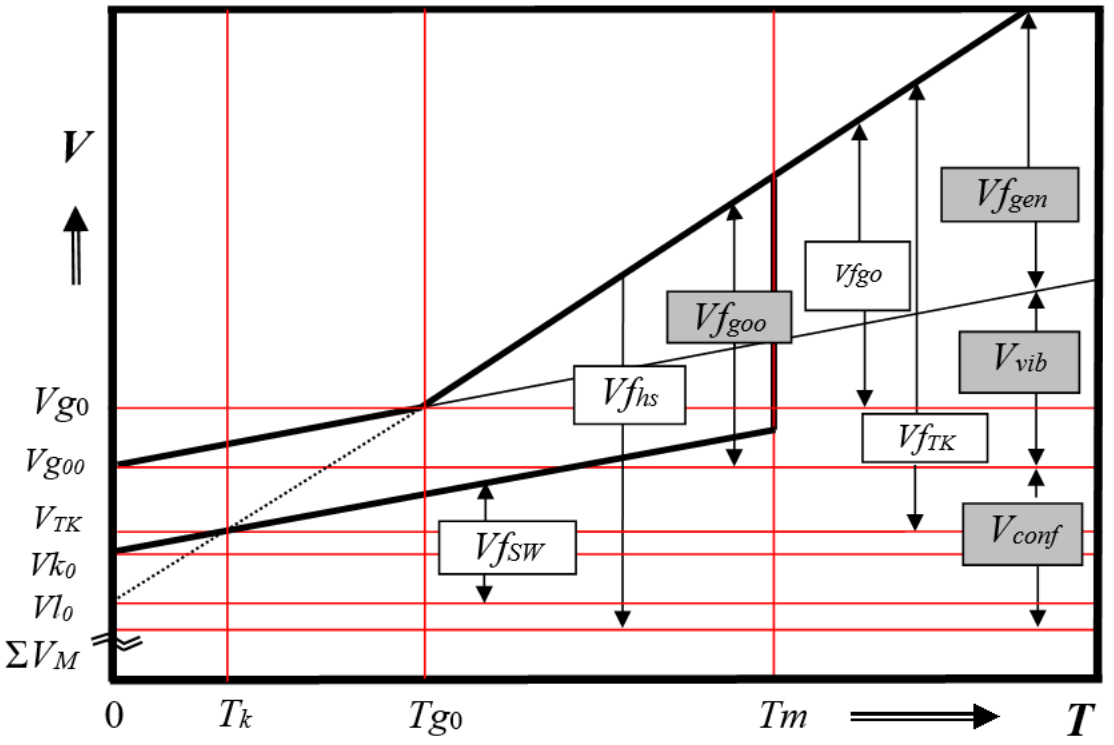
Figure 3. Possibilities to define free volume. (To simplify things, the graphic does not consider the influence of the possibilities of axis orientation and vapor pressure).